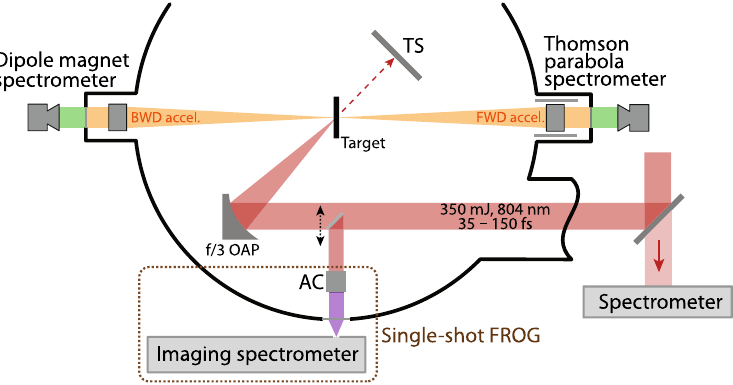
Figure 4. Illustration of the experimental setup. TS denotes the Spectralon screen detecting transmitted laser light, OAP is the focusing off-axis parabola, and AC stands for